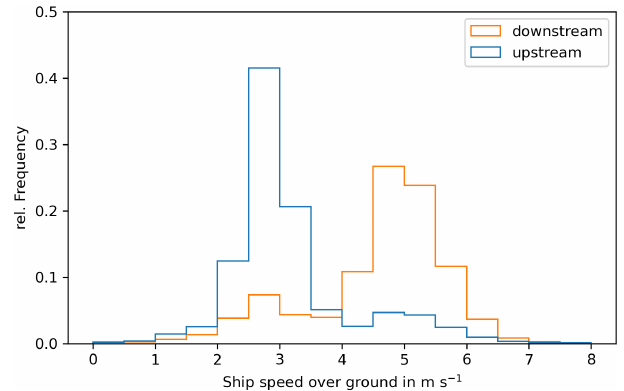
Figure 6. Ship traffic and fleet composition at DURH between November 2017 and December 2021. In total, 291635 ship pas- sages have been identified.